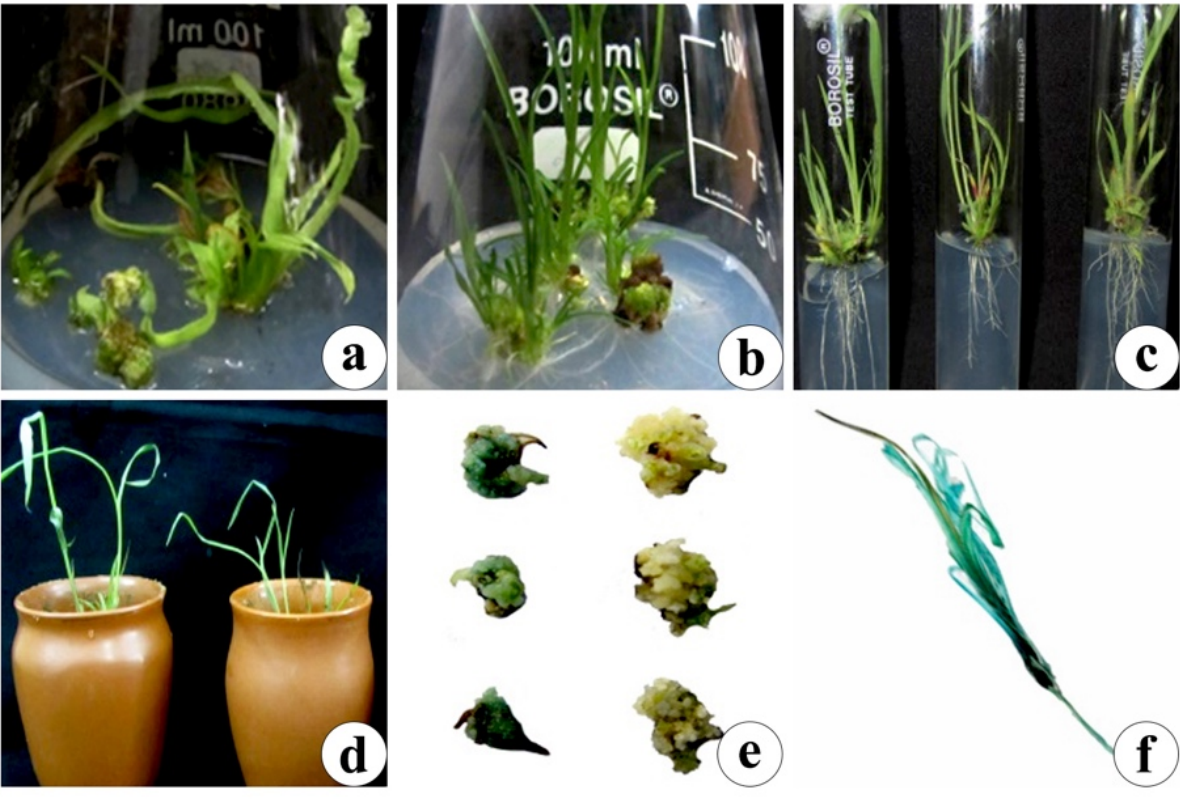
Figure 5. ( a , b )PlantletRegenerationonMS+0.5mg/lNAA+2mg/lBAP;( c )RootingofregeneratedshootsonMS + 0.5 mg/l PAA; Figure 5. ( a , b ) Plantlet Regeneration on MS + 0.5 mg/l NAA + 2 mg/l BAP; ( c ) Rooting of regener- ( d ) Regenerated plants transferred to pots and ( e , f ) GUS histochemical ated shoots on MS + 0.5 mg/l PAA; ( d ) Regenerated plants transferred to pots and ( e , f ) GUS histo- chemical assay.